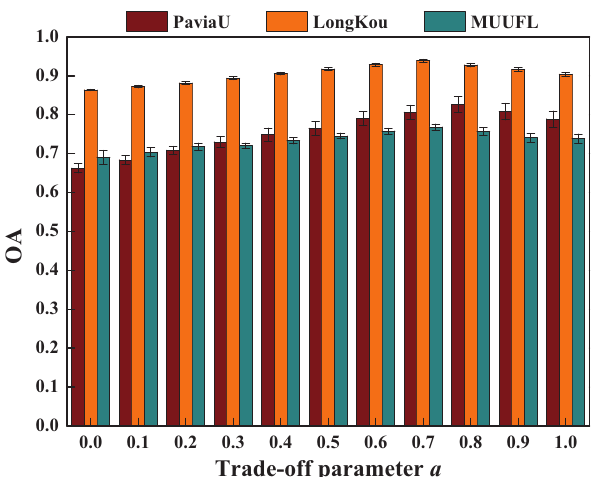
Figure 7. Classification results of LMSCPE with different tradeoff parameter a on three HSI data